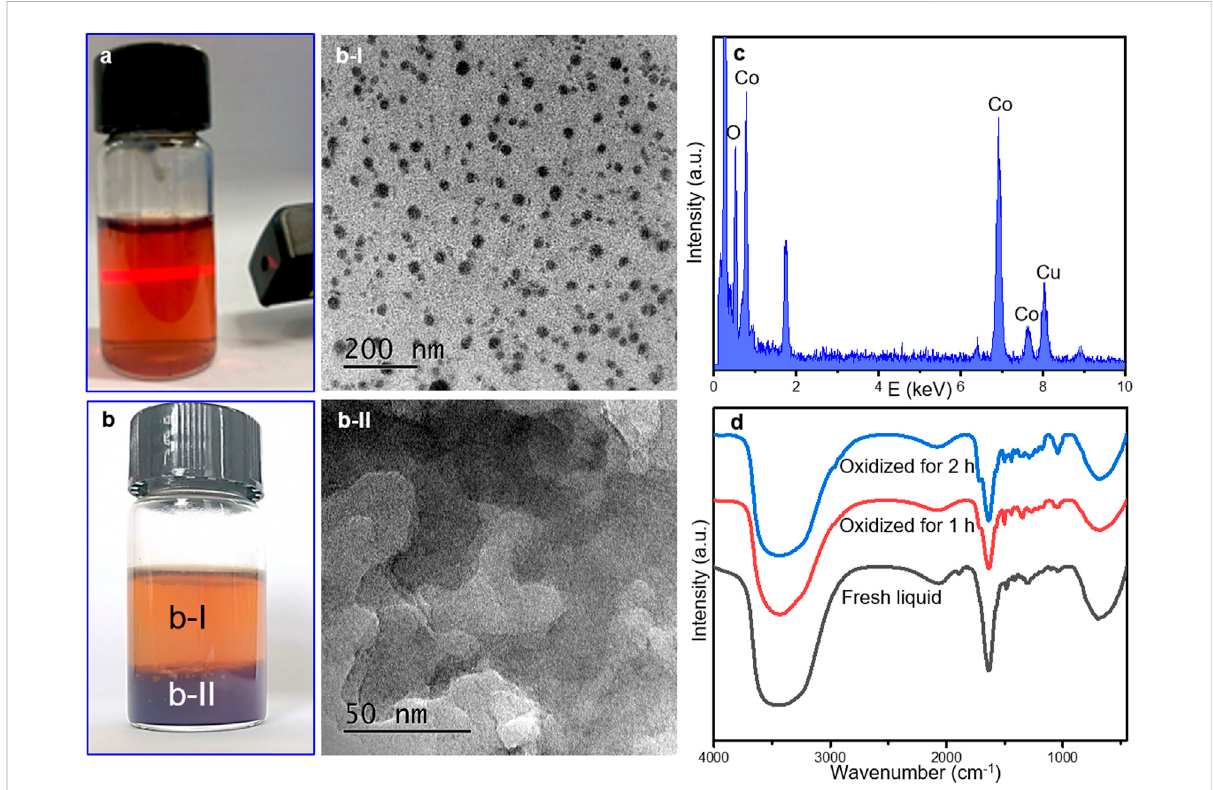
FIGURE 3 Electronicpicturesoffreshmixtureextractedimmediatelyafterreaction (A) andtreatedbyoxidizationwithpureO 2 atroomtemperaturefor2 h (B) , (B-I) , and (B-II) illustratedthe TEM images ofsupernatant liquid and under-layer depositionin b. (C) TEM/EDX analysis of theB-II sample, and (D) FT-IR spectra of fresh mixture after reaction without and with O 2 fl owing at room